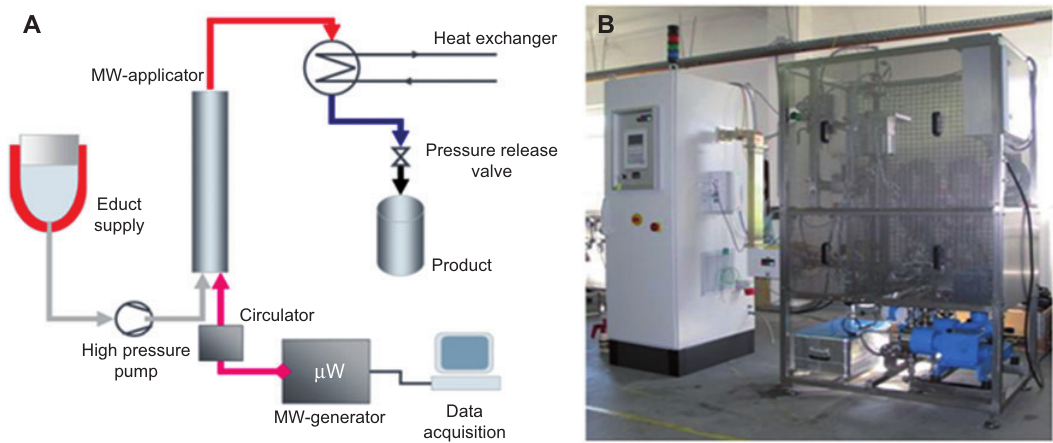
Figure 4 ( A ) General design of the continuous microwave synthesis unit; ( B ) graphical image of the